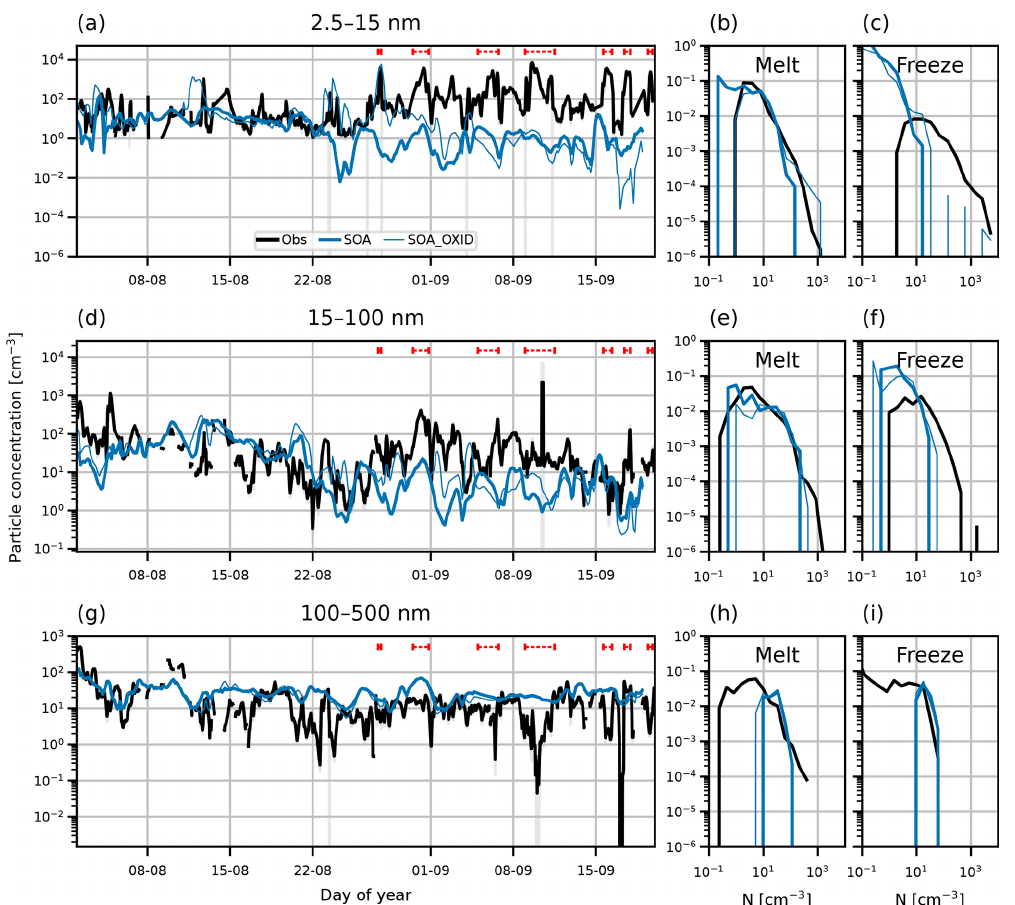
Figure E1. Time series and PDFs of surface aerosol concentration during AO2018 from observations and model output. Model output is from simulations SOA (thick blue lines) and SOA_OXID (thin blue lines). Observations are shown as 3-hourly mean (black lines) and standard deviation (grey shading). Aerosol concentrations are shown for particles with diameter (a–c) 2.5–15nm, (d–f) 15–100nm, and (g–i) 100–500nm. Dashed red lines in (a) , (d) , and (g) show observed NPF events. PDFs are separated by observed sea ice freeze-up date, 27 August 2018 (day